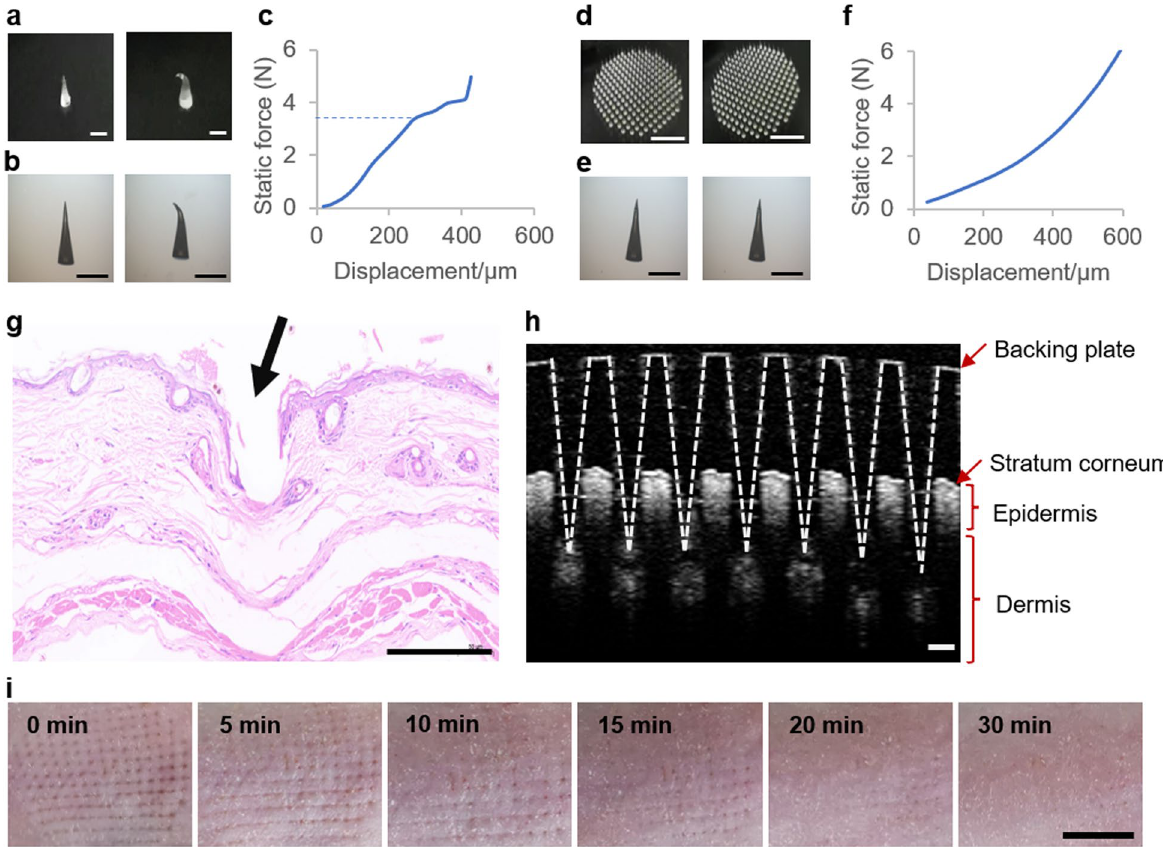
Fig. 2 Characterization of the MNA. Pictures of microneedle taken with cameras a and microscopes b showed that the tip of the microneedle was bent after compression tests. (Scale bars: 500 μm). c Force-displacement curve of a single MN. The largest deformation occurred at approximately 3.3 N compression force. d The camera pictures of the MNA indicated no obvious change after compression tests. (Scale bar: 500 mm). e Microscopic images of one needle from the array showed no obvious difference between before and after compression tests. (Scale bar: 500 μm). f The force-displacement curve of the MNA showed no obvious turning point. H&E-stained cross-section g and OCT h revealed that the MNA could penetrate the epidermal layer of the skin. (Scale bars: 200 μm). i Skin pictures recorded the quick skin healing after the treatment of the round-shaped MNA. (Scale bar: 500